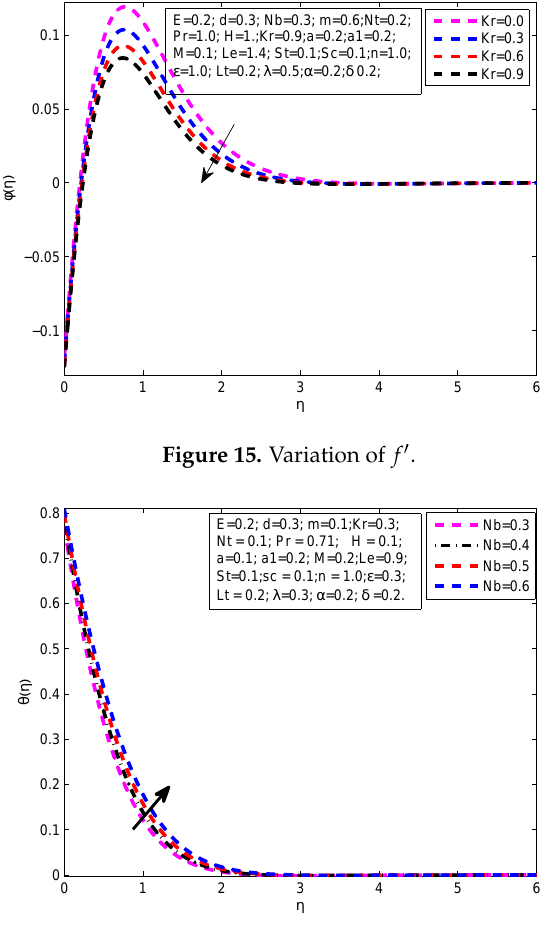
Figure 16. The behaviour of Nb on θ